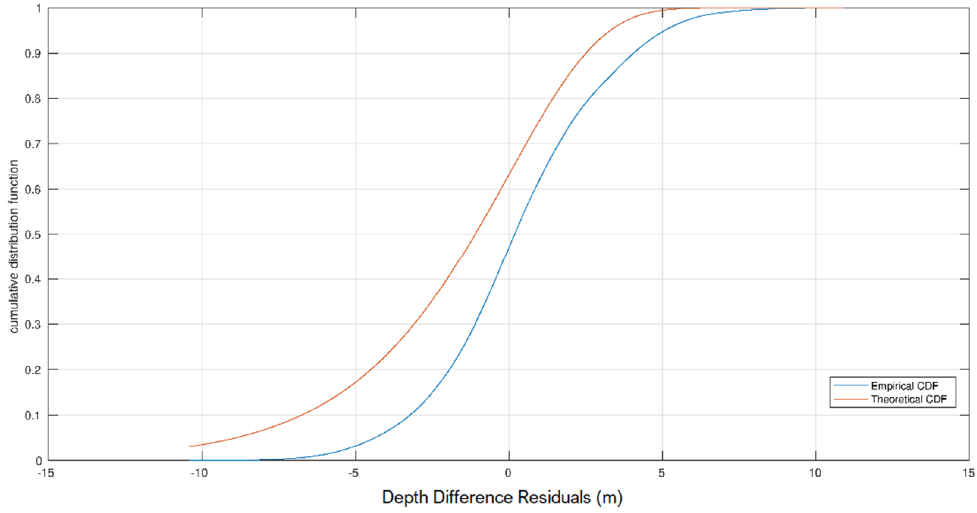
Figure 18. The histogram of the relative residuals calculated based on the 2nd order surface fit.